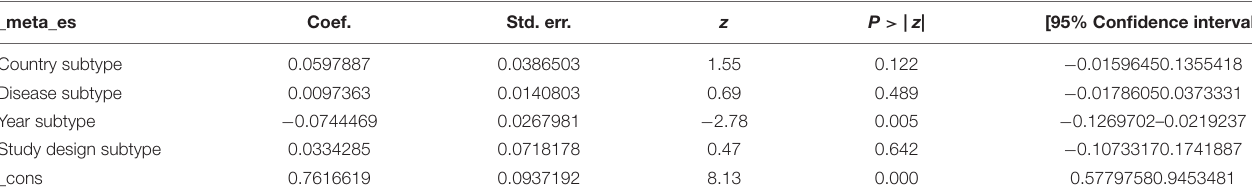
TABLE 3 | Random-effects meta-regression to investigate the reason for heterogeneity of the percentage of therapeutic interventions in all endoscopic retrograde cholangiopancreatography (ERCP) procedures. _meta_es Coef. Std. err. z P > | z |